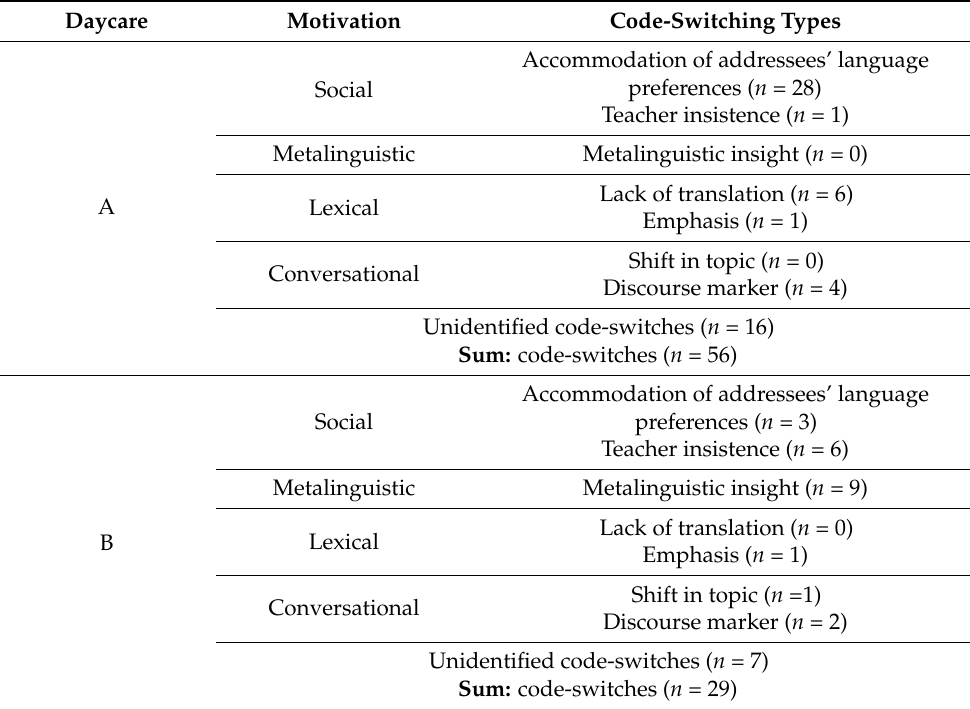
Table A1. Distribution of code-switching types across the English